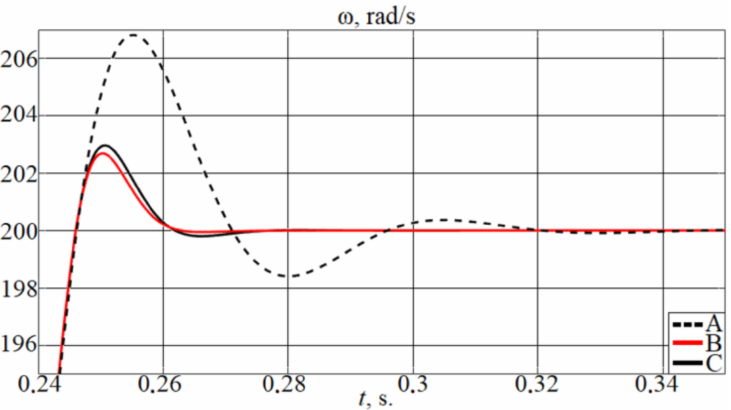
Figure 7. Comparison of motor speed curves when τ e = 0, ˆ K ref ( 0 ) − K ref (cid:54) = 0 and ˆ K ( 0 ) − K (cid:54) = 0.